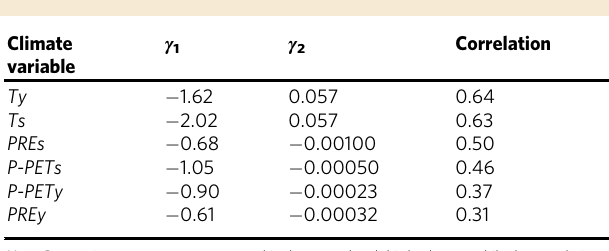
Table 1 Empirical climate – β 2 models (Eq. 2) considering different (temporally averaged) climate variables ( fi rst